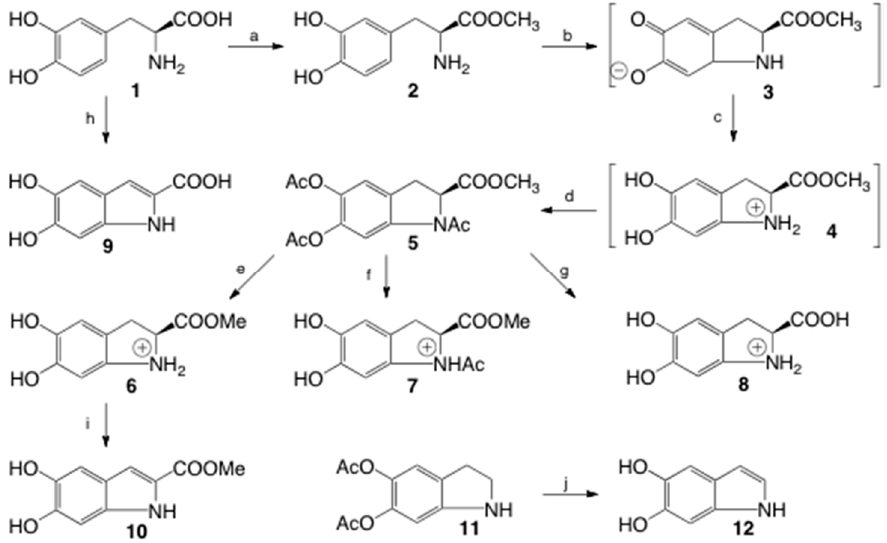
Figure 1. Synthetic scheme for the preparation of cycloDOPA derivatives. (a) SOCl 2 , MeOH, reflux, 1h, quant; (b) K 3 [Fe(CN) 6 ], sodium phosphate (pH = 8), 0 °C, 75 s; (c) Na 2 S 2 O 4 , sodium phosphate (pH